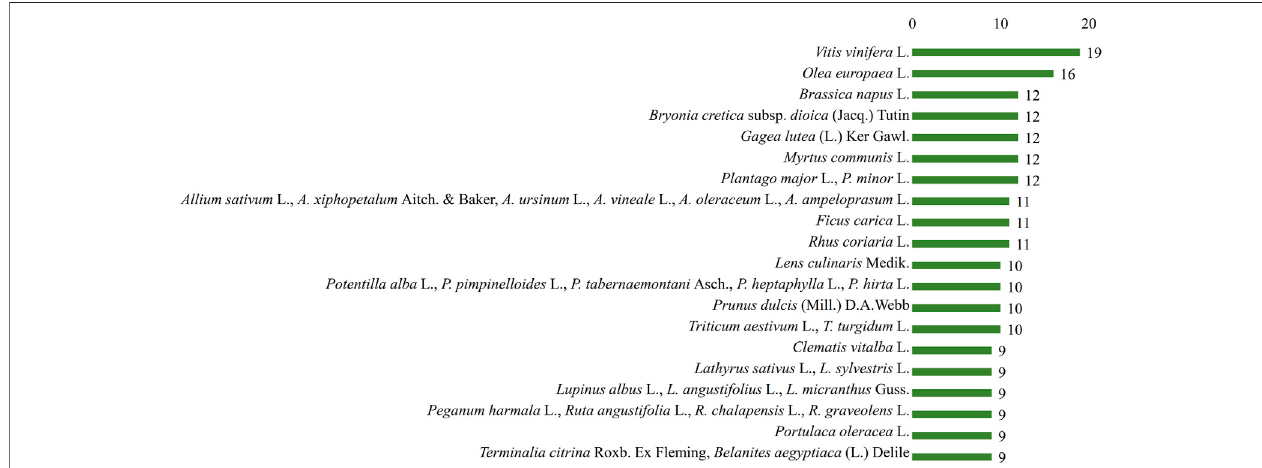
FIGURE 9 | Suggested species with the highest number of reported uses according to Dioscorides.